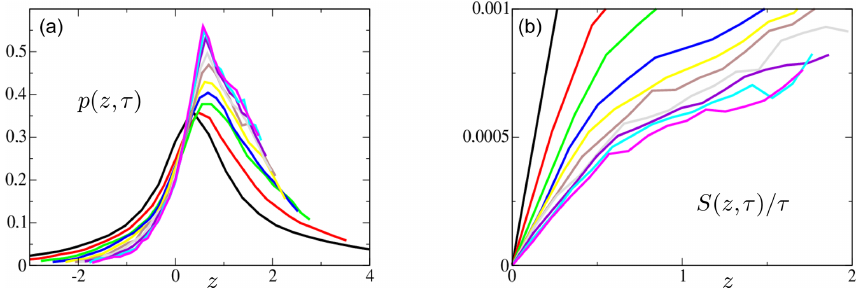
Figure 4. The pdf p(z,τ) (a) and the symmetry function normalized by the averaging time S(z,τ)/τ (b) as a function of z for different averaging times τ (see caption and legend of Fig. 1); data are for case KUE, res 0.5 ◦ , 1993–2016, res